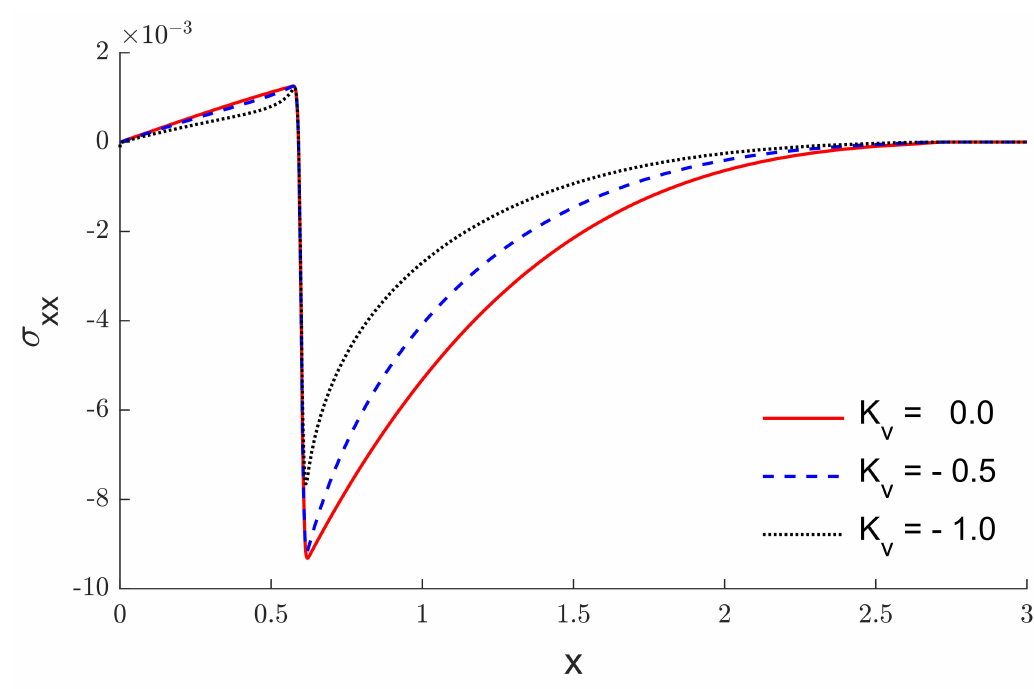
Figure 3. The stress variation via the distance with three values of K v